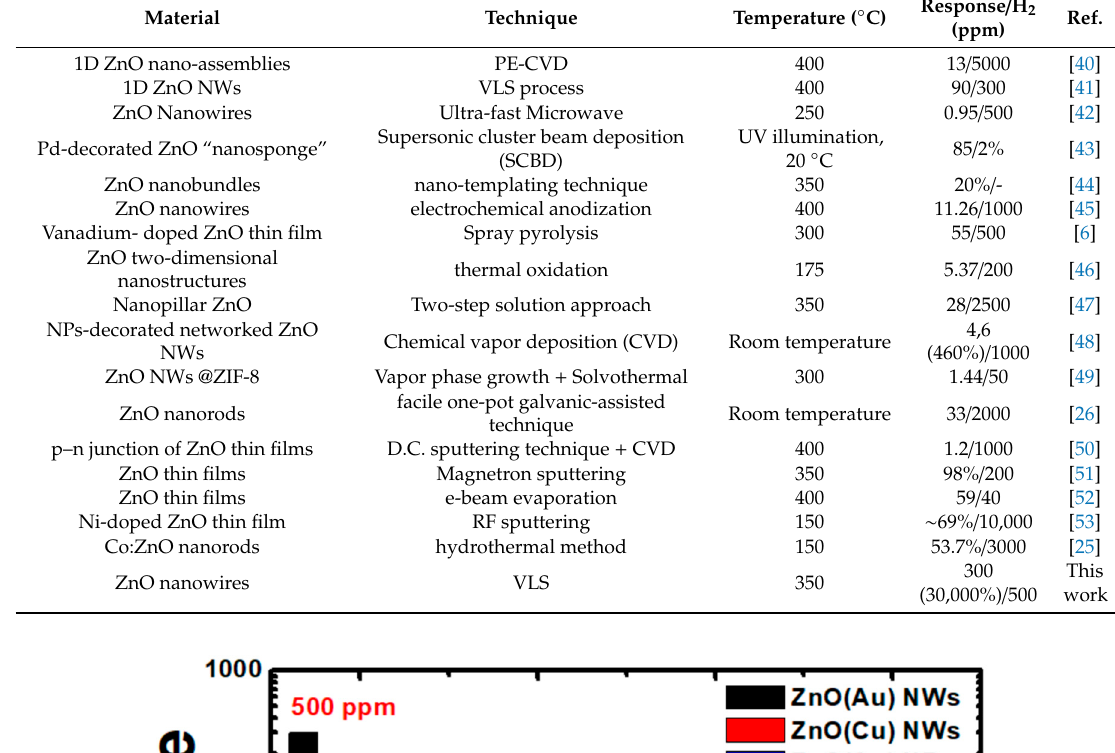
Table 4. Studies reporting Hydrogen sensor based on ZnO nanomaterial.